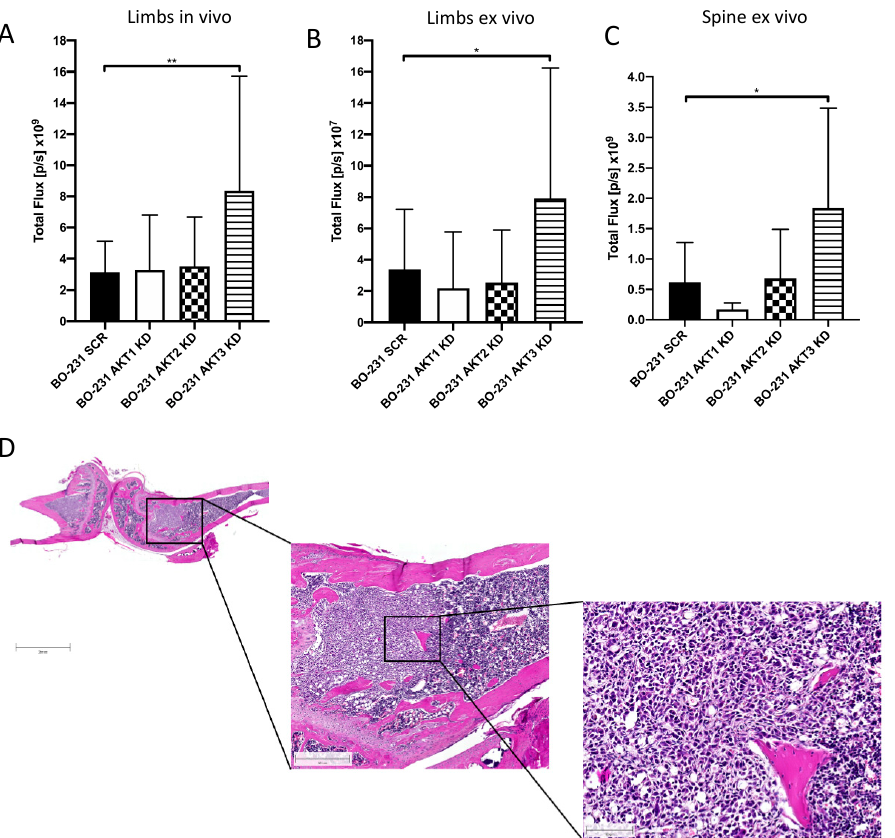
Figure 6. Knockdown of AKT3 in 231-BO cells shows increased metastasis to bone after intracardiac inoculation in NOD scid gamma (NSG) mice: To test the effect of AKT isoform knockdowns on metastasis in an in vivo model, 231-BO cells with AKT isoform knockdowns were transduced with a luciferase vector and were inoculated into the left ventricle of NSG mice. Correct injection, tumor cell dissemination, and growth were monitored by measurement of bioluminescence. Mice were sacrificed after 21 days, exenterated, and hind limbs as well as lumbar vertebrae were harvested. Bioluminescence intensities of hind limbs of living mice (SCR and AKT1 KD: n = 16; AKT2 KD and AKT3 KD n = 18) ( A ), of hind limbs ex vivo (SCR and AKT1 KD: n = 16; AKT2 KD and AKT3 KD n = 18) ( B ), and of the spine ex vivo (SCR and AKT1 KD: n = 8; AKT2 KD and AKT3 KD n = 9) ( C ) were measured by an IVIS imaging system after intraperitoneal luciferin injection. Bars indicate mean with SD; * = p < 0.05, ** = p < 0.01. ( D ) Right hind limbs were decalcified, embedded, and histological slices were generated. HE staining was used to confirm the presence of intraosseous tumor colonization. Image represents slices from a mouse injected with 231-BO AKT3 KD cells. Scale bars represent following dimensions: left image: 2000 µ m; middle image: 500 µ m; right image: 100 µ